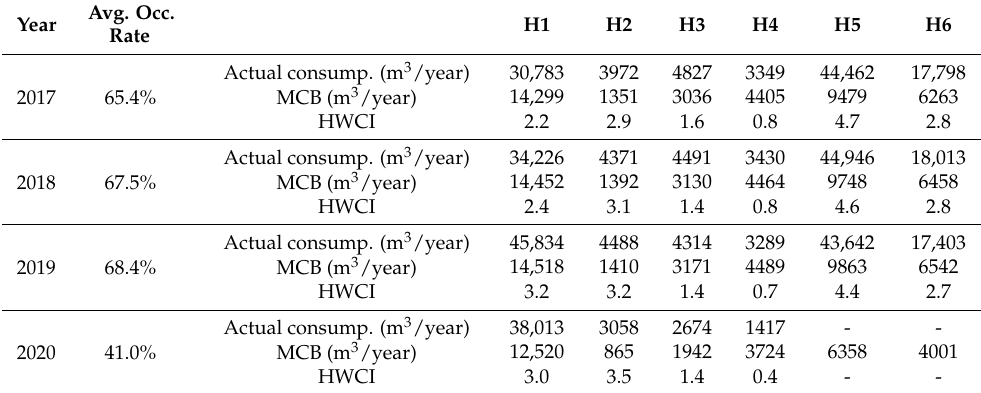
Table 18. HWCI results for all six hotels from 2017 until